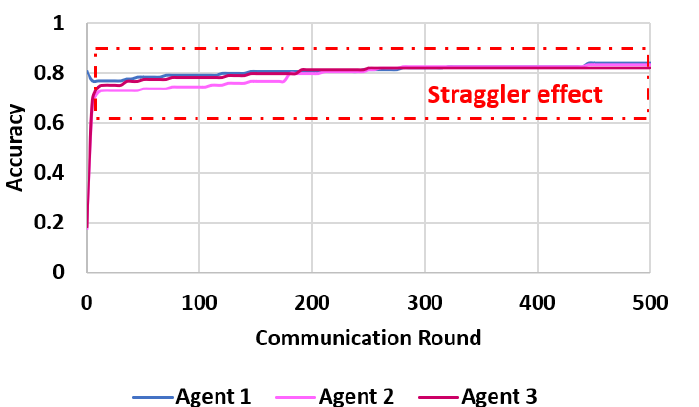
Figure 10. Straggler effects on participating FL agents’ (three agents and two stragglers) model accuracy for the prediction of agents’ resource-sharing capability.